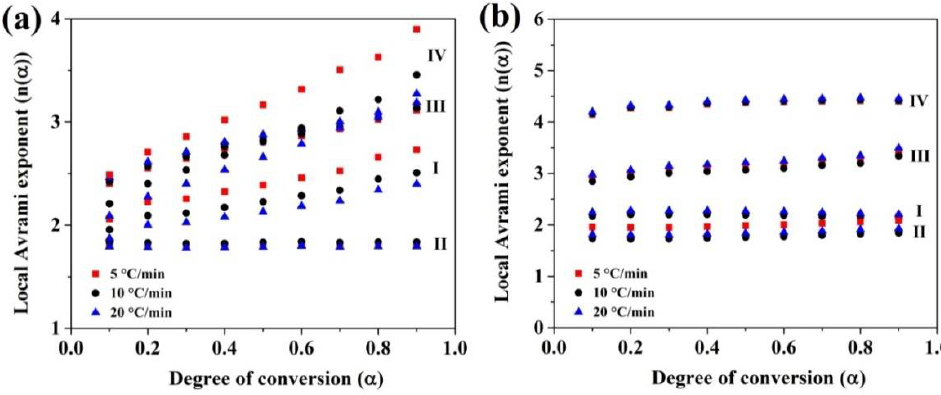
Figure 7. Local Avrami exponent ( n ( α )) as a function of α for all crystallization stages of (Fe 41 Co 7 Cr 15 Mo 14 Y 2 C 15 B 6 ) 100−x Cu x amorphous alloys; where ( a ) 0.25 at.%; ( b ) 0.5 at.%.